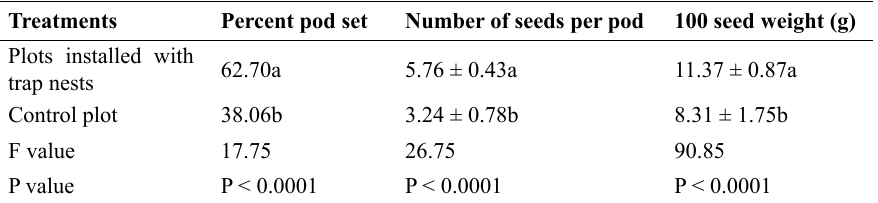
Table 4. Pollination efficiency of leafcutter bees Megachile Latreille, 1802 and yield parameters of pigeon pea ( Cajanus cajan (L.) Millsp., Fabaceae) in the experimental farm of ICAR-National Bureau of Agricultural Insect Resources (NBAIR) Bengaluru, Yelahanka Campus, India